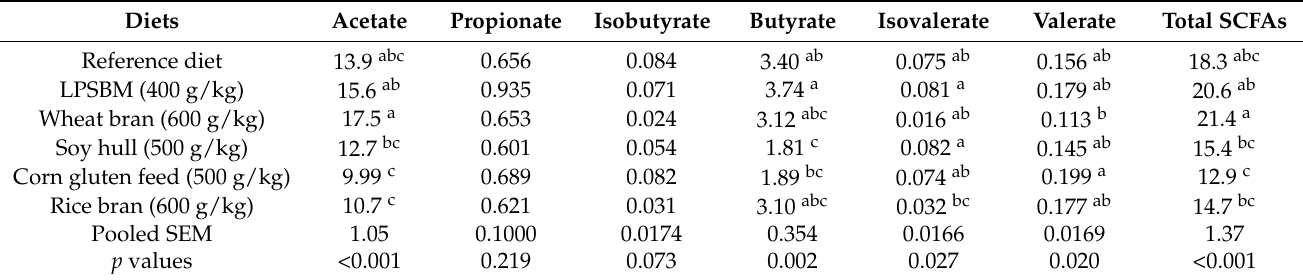
Table 6. Cecal short-chain fatty acid (SCFA, mM) composition in response to short-term feeding of high levels of high-protein or high-fiber feedstuffs in a corn–soybean meal reference diet during metabolizable energy assay.